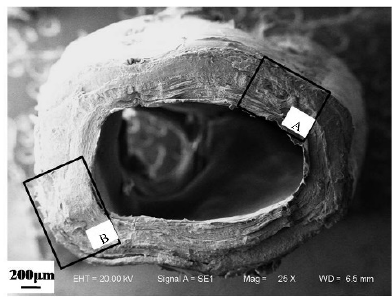
Figure 5. Concave ( A ) and convex ( B ) areas of the dactylopodite seen in cross section.